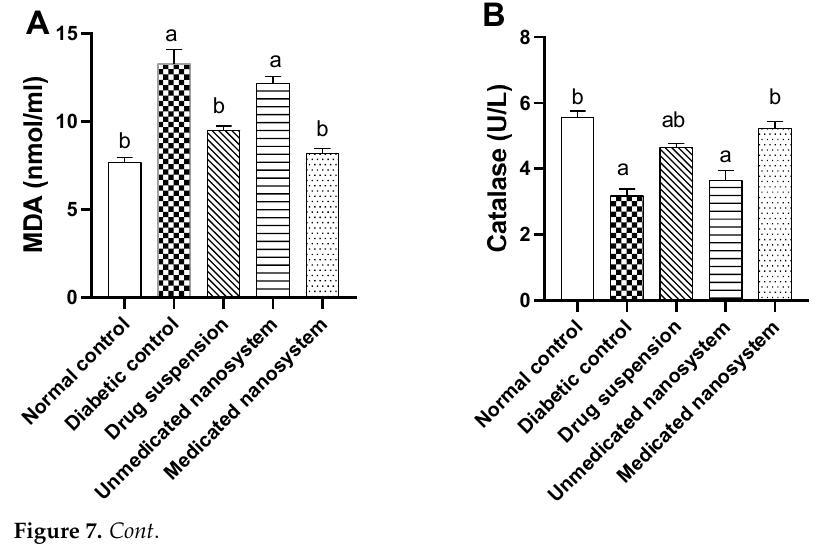
Figure 7. Effect of β -sitosterol glucoside on MDA ( A ), catalase ( B ), and glucagon levels ( C ) in STZ- induced diabetic rats. Each value denotes mean ± SEM ( n = 6). Statistical analysis was carried out by one-way ANOVA followed by Tukey’s post-hoc test. a significantly different from normal control. b significantly different from diabetic control at p < 0.05. Insulin resistance, increasing β -cell dysfunction, poor glucose consumption, and T2DM have all been linked to oxidative stress [48]. Chronic hyperglycemia boosts tissue ROS and lipid peroxidation, impairing insulin action [49]. Moreover, antioxidant enzymes such as CAT play a crucial role in overcoming oxidative stress [50]. In the present study, as shown in Figure7, in comparison to the normal control group, the serum of the diabetic control group exhibited a large increase in MDA, a lipid peroxidation product [51], and a significant decrease in catalase activity. These findings are supported by previous reports [52-54]. The medicated nanosystem-treated group mitigated oxidative stress in the serum of T2DM rats by decreasing the serum level of MDA and subsequently increasing the se- rum level of CAT.